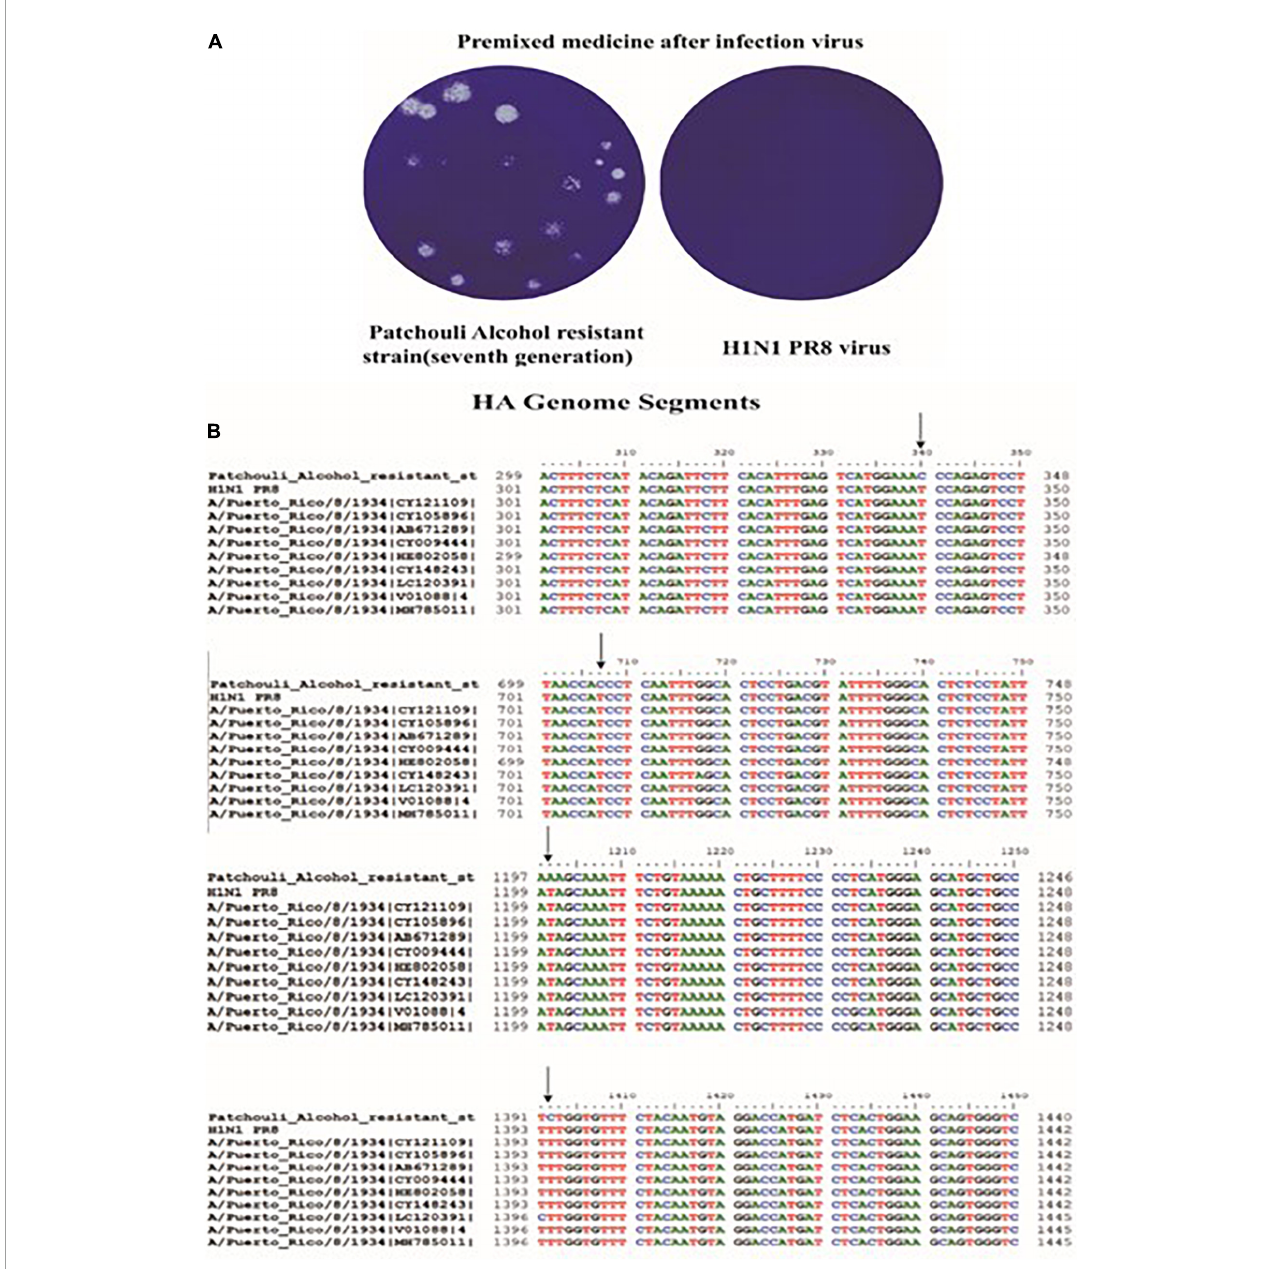
FIGURE6 Culture and sequence comparison of Patchouli-alcohol-resistant strains. (A) Patchouli-alcohol-resistant strains detected by plaque reduction assay. (B) Sequence comparison of Patchouli-alcohol-resistant